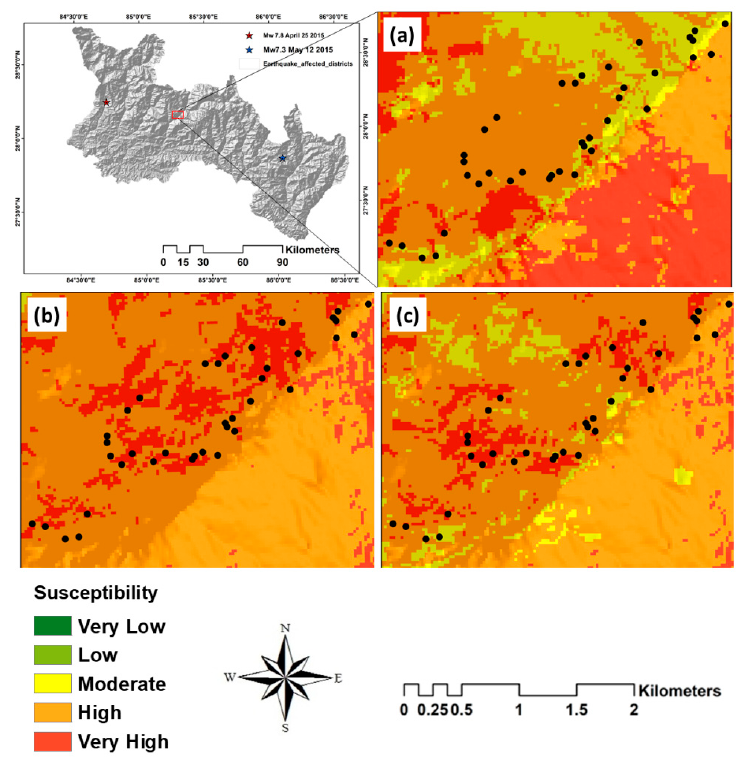
Figure 5. An example the performance of the three landslide susceptibility models in a sub-area of the case study area. ( a ) Frequency ratio; ( b ) analytical hierarchy process; ( c ) spatial multi-criteria evaluation.